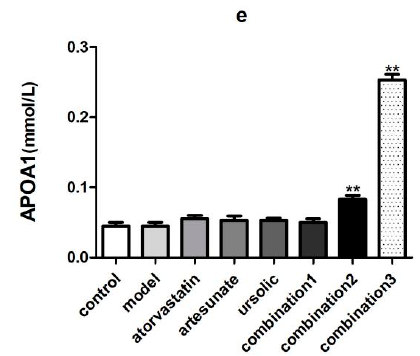
Figure 1. The effect of each administration group on lipid-related metabolites in high-fat rats. The groups were divided as eight groups: control group; model group; positive control (atorvastatin group, 10 mg/kg); artesunate group (20 mg/kg); ursolic acid group (20 mg/kg); combination group 1 (artesunate 10 mg/kg + ursolic acid 10 mg/kg); combination group 2 (artesunate 20 mg/kg + ursolic acid 20 mg/kg); and combination group 3 (artesunate 40 mg/kg + ursolic acid 40 mg/kg). Values are represented as mean ± SD. Significant difference vs. the model group (** p < 0.01). ( a ) showed the serum level of cholesterol in each group; ( b ) showed the serum level of triglyceride in each group; HDL-C to LDL-C in the plasma in each group; Figure 1e showed the serum level of APOA1 in each group. 2.2. Artesunate/Ursolic Acid Combination Therapy Has Lower Liver Toxicity Compared with Atorvastatin